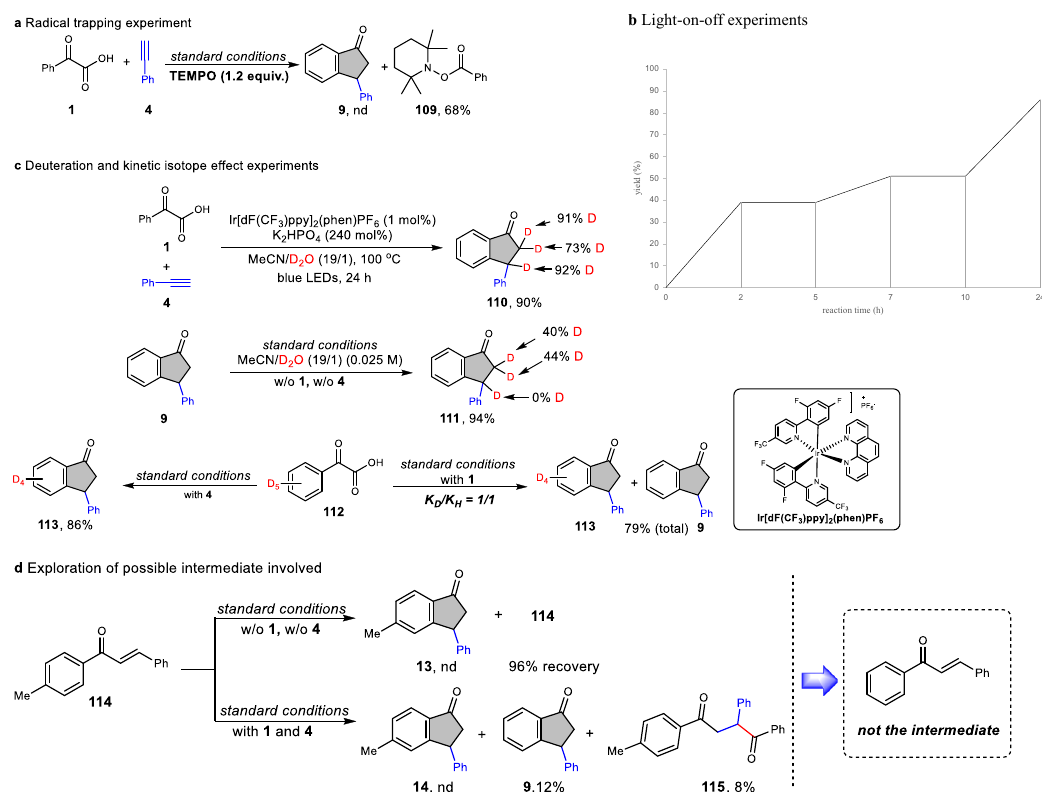
Fig. 8 Mechanistic studies. a Radical-trapping experiment with 2,2,6,6-tetramethylpiperidinooxy (TEMPO). b Light-on – off the experiment. c Deuterated and kinetic isotope experiments. d Exploration of possible intermediate